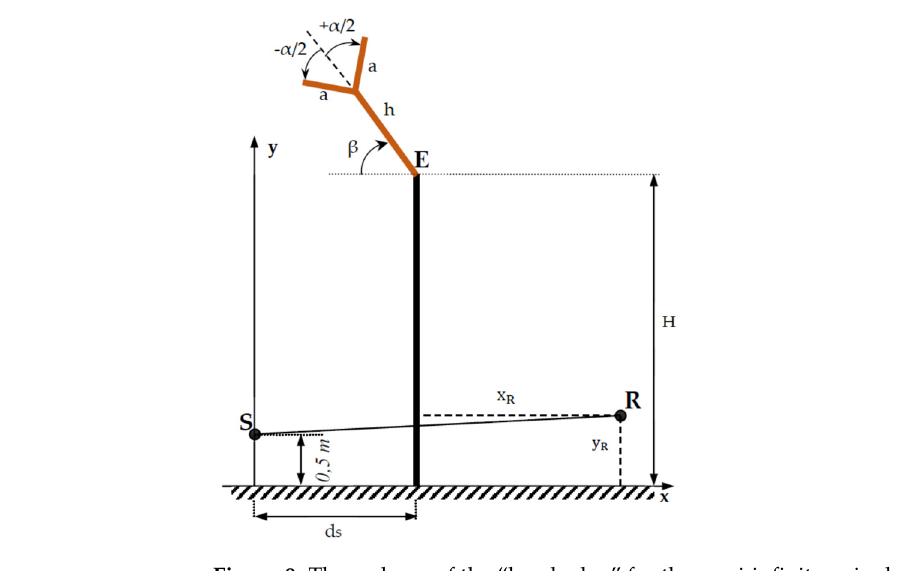
Figure 9. The y-shape of the “head edge” for the semi-infinite noise barrier.